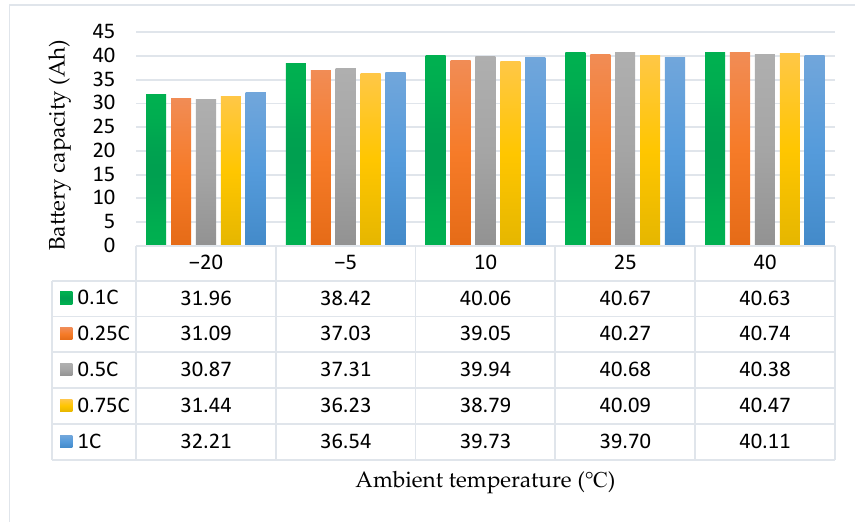
Figure 6. Discharge capacity comparison chart.